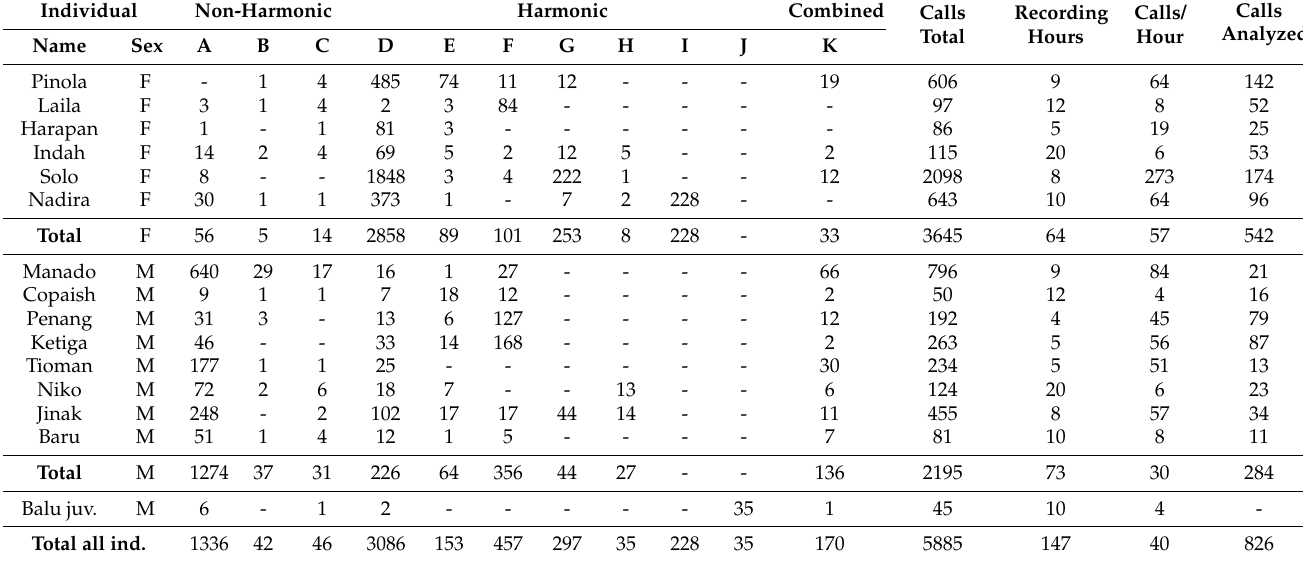
Table 3. Distribution of the 11 different call types as well as hours of recording, calls per recording hour, and number of analyzed calls for each individual. To show the frequency in call usage over time, the total number of calls per subject was divided through the total recording time of each